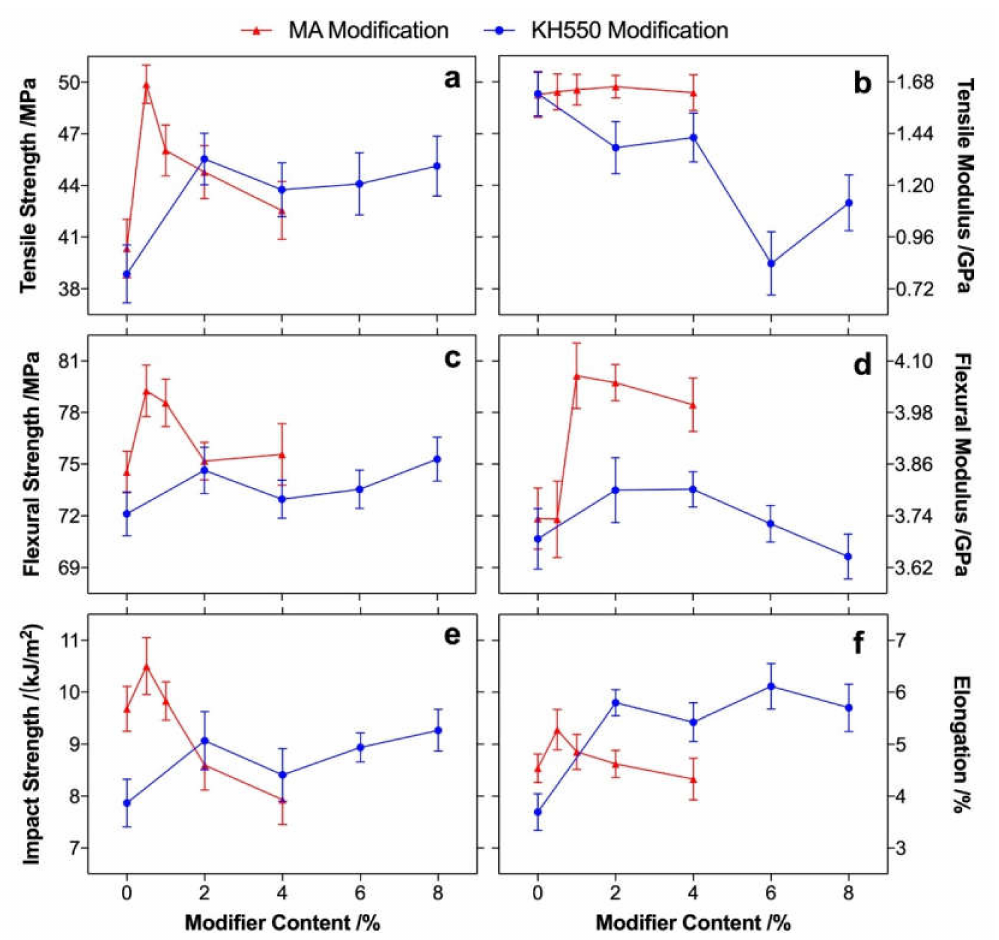
Figure 4. Tensile strength ( a ), tensile modulus ( b ), flexural strength ( c ), flexural modulus ( d ), impact strength ( e ), and elongation ( f ) of the MA- (triangle) and KH550- (circle) modified poplar fiber / PLA